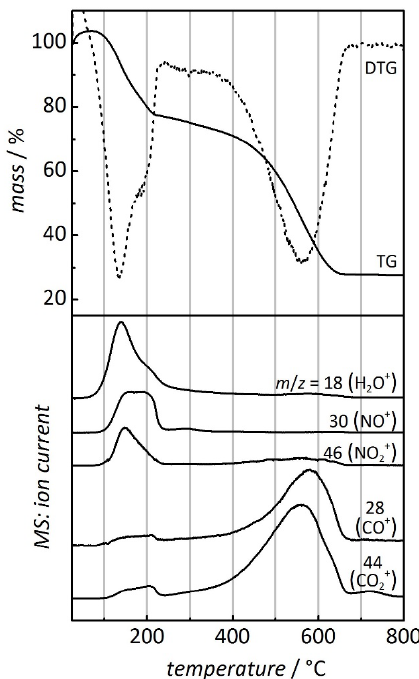
Figure 2. Thermogravimetric/derivative thermogravimetric (TG/DTG, ( top )) and mass